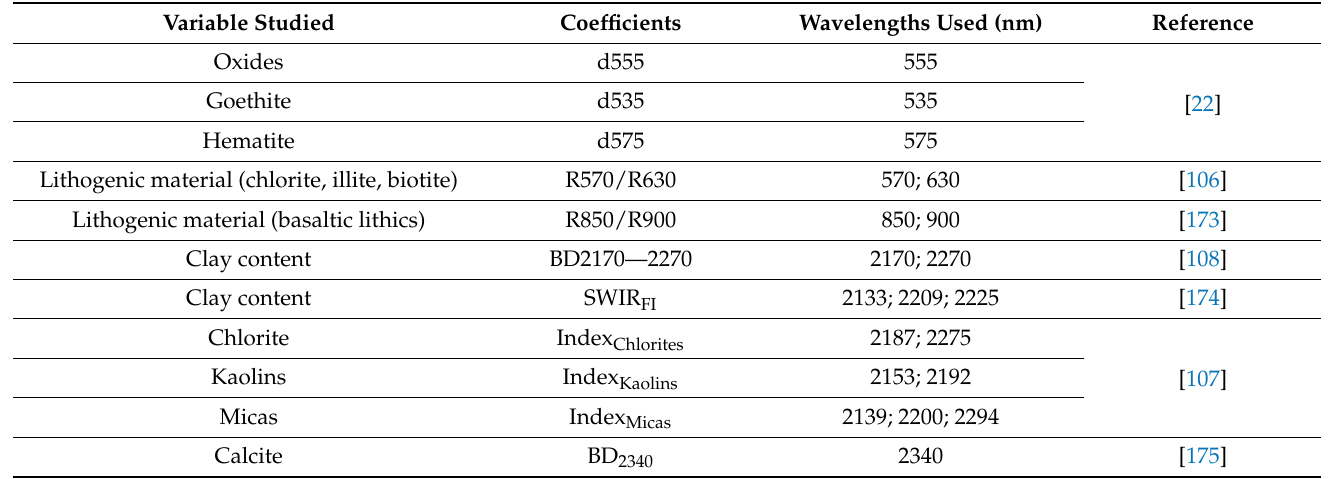
Table 4. Some spectroscopic coefficients reported in the literature for the visible and near-infrared spectral ranges for different samples (sediments, rock and